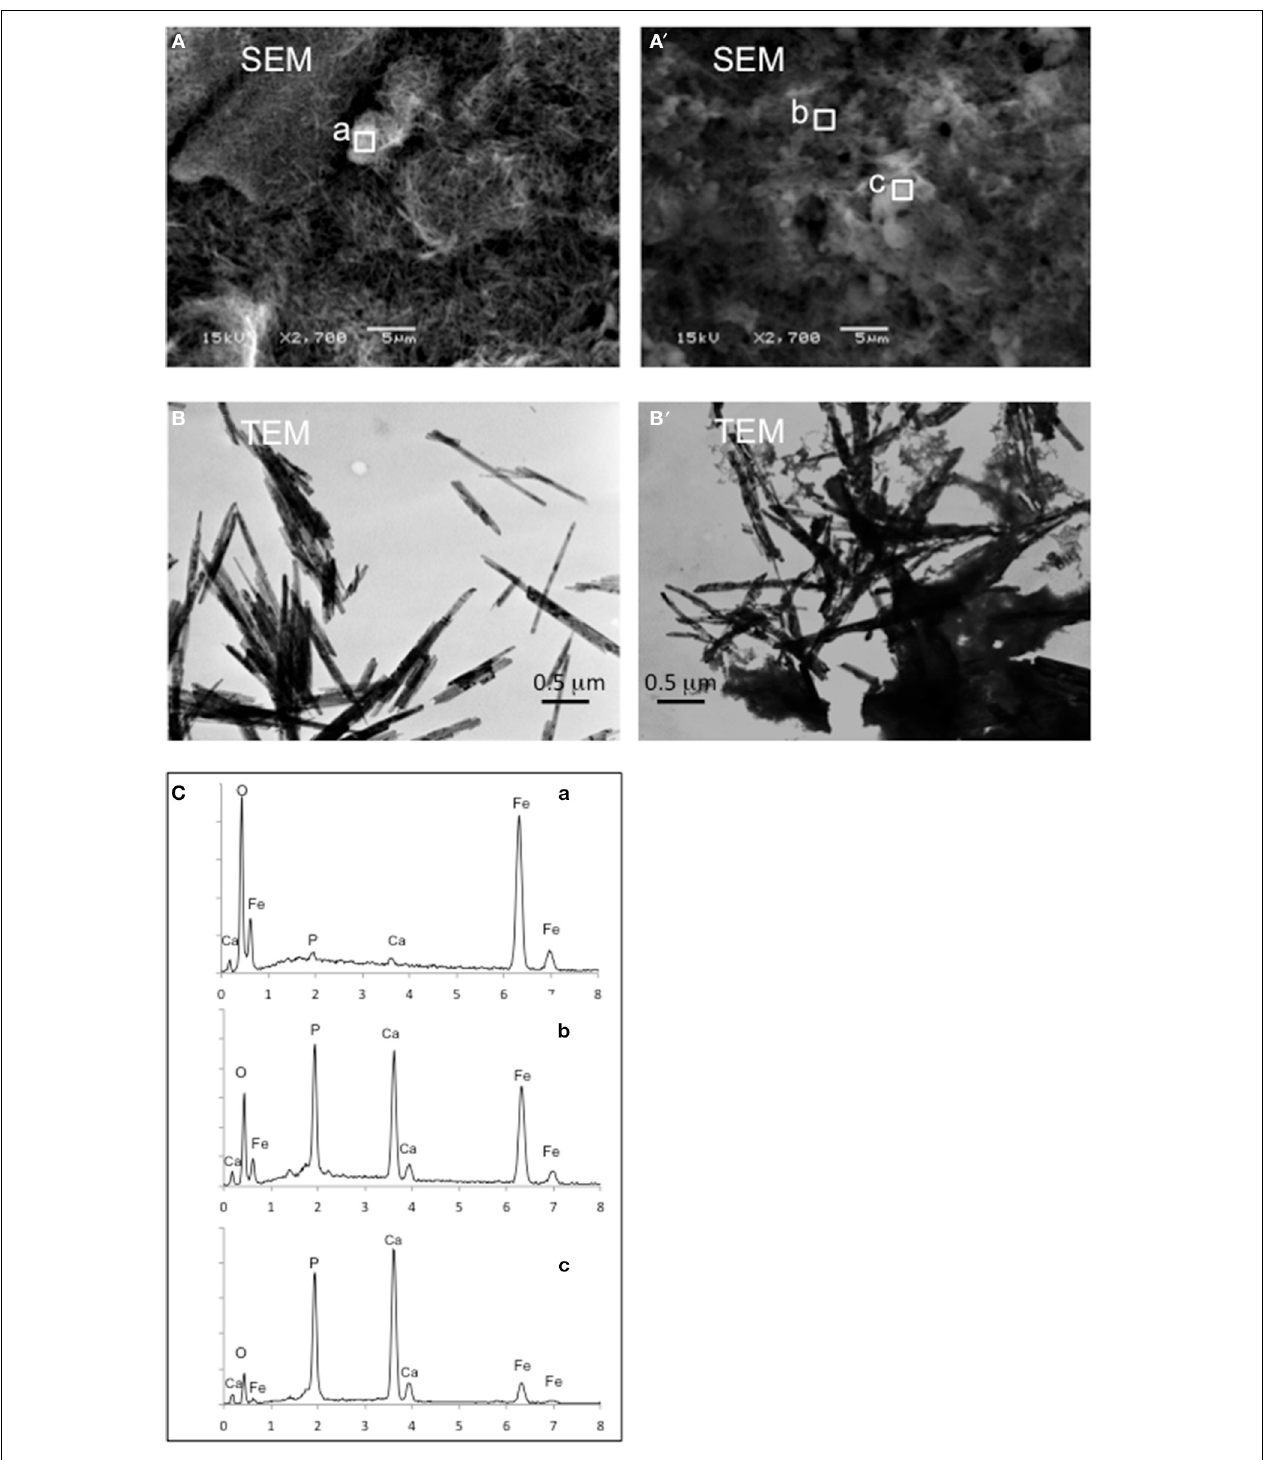
FIGURE 6 | Mineral morphology and element composition identified by SEM, TEM and SEM-EDX for goethite reduction by IBDP6634. The control samples prepared and incubated under the same condition but without cell